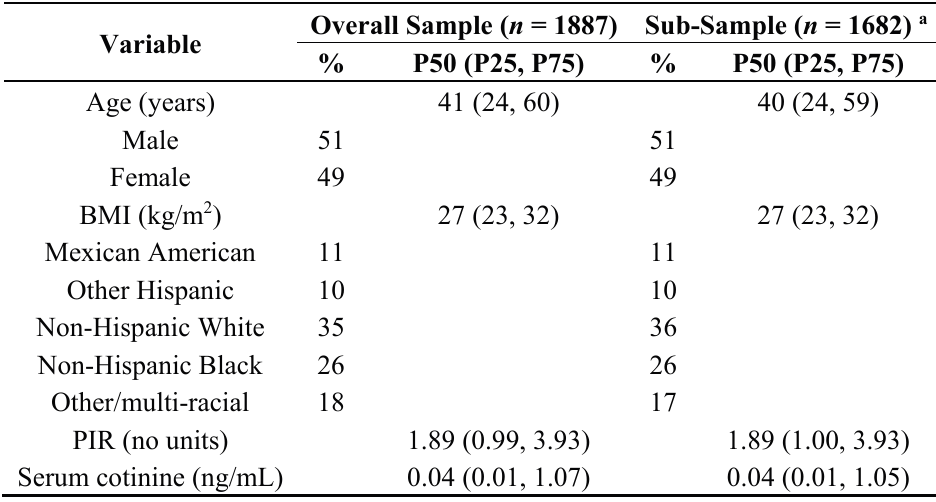
Table 1. Characteristics of participants from NHANES 2011–2012.